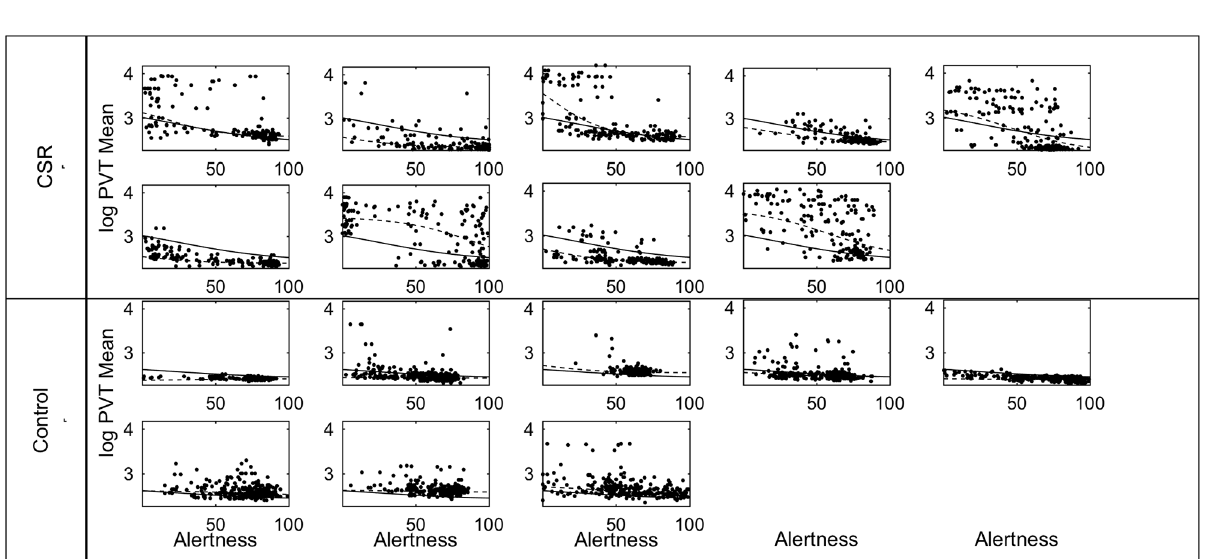
Fig 7. PVT mean vs. Subjective Alertness for each participant. The same data as in Fig 6 are plotted separately for each participant. Logistic fits are shown with fixed effects (solid black line) and with mixed effects (dashed line).